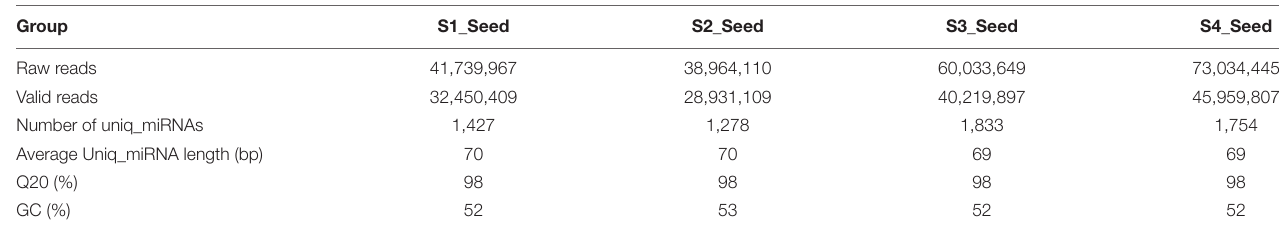
FIGURE 1 | Phenotypic observation and fatty acid determination during sesame seed development. The developmental process of sesame seeds (S1–S4) (A) . Collection time was at 7, 14, 21DAF, and until 28 days after flowering (DAF) (the time point of seed maturity). (B) The oil content percent of sesame seed at four time points. (C) The percent of different fatty acid compositions at four time points of sesame seed. TABLE 1 | Data analysis of transcriptome sequencing for Sesamum indicum